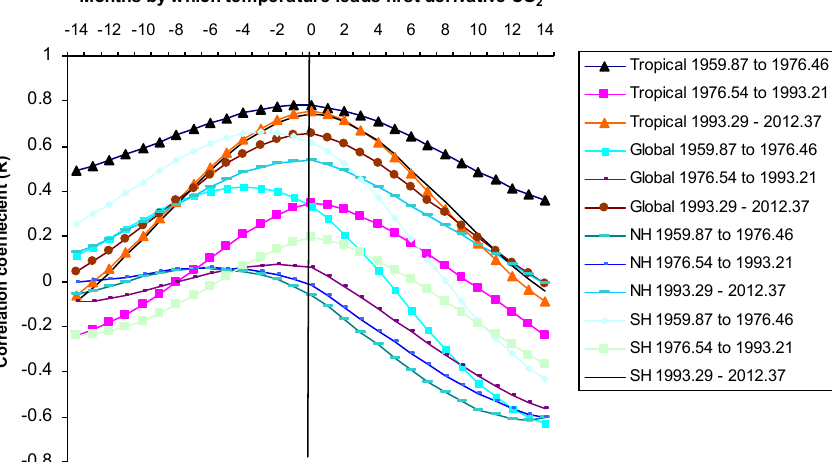
Figure 5. Correlograms of first-difference CO 2 with surface temperature for global, tropical, Northern Hemisphere and Southern Hemisphere categories, each for three time-series sub-periods.